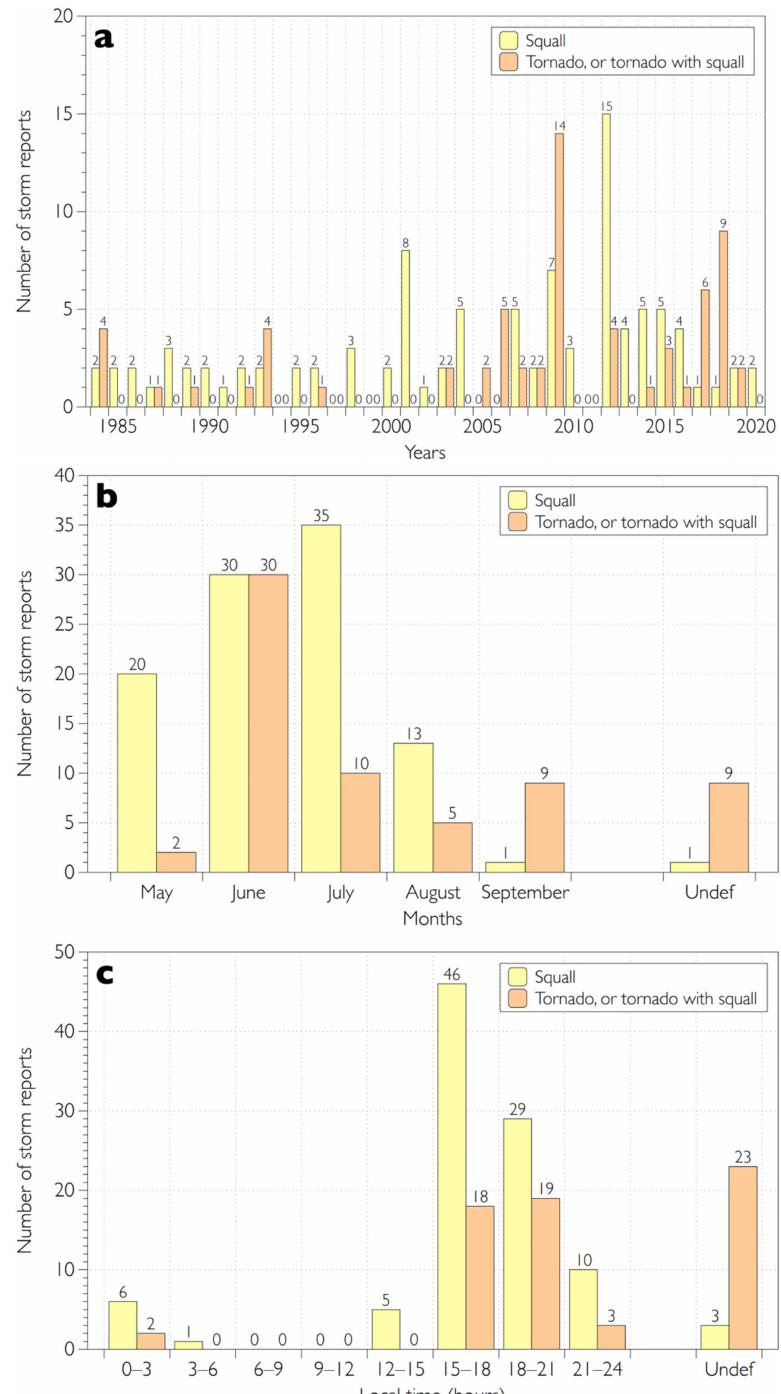
Figure 6. Number of ( a ) squall and tornado reports per year, ( b ) in each month of the year, and ( c ) in 3-h interval of a day ( c